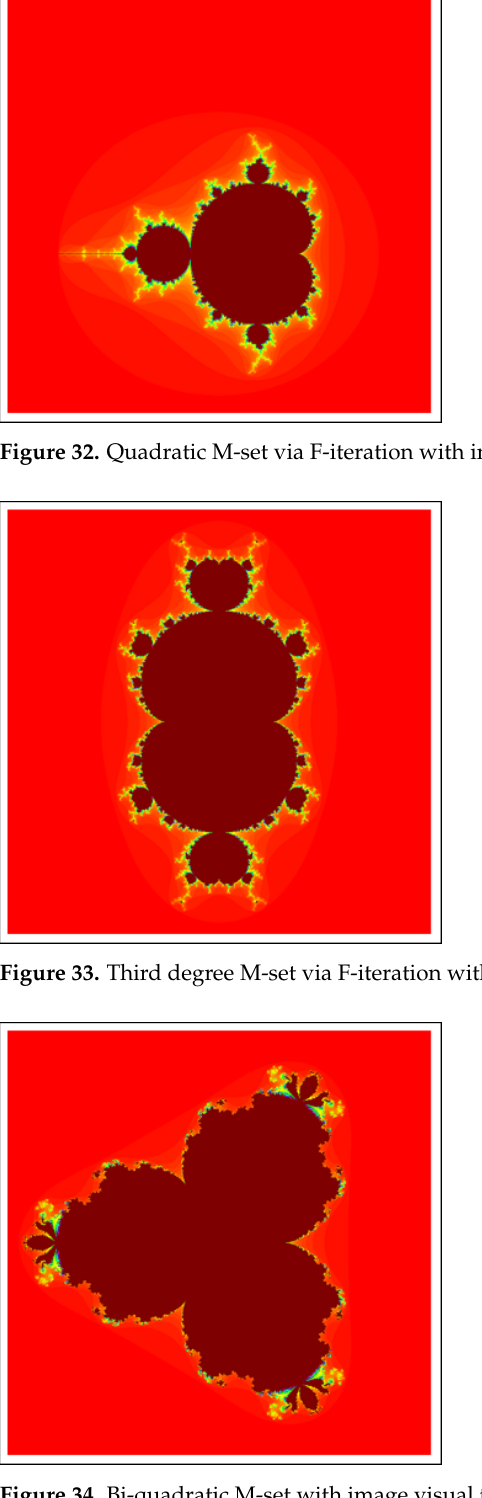
Figure 34. Bi-quadratic M-set with image visual time = 148.6